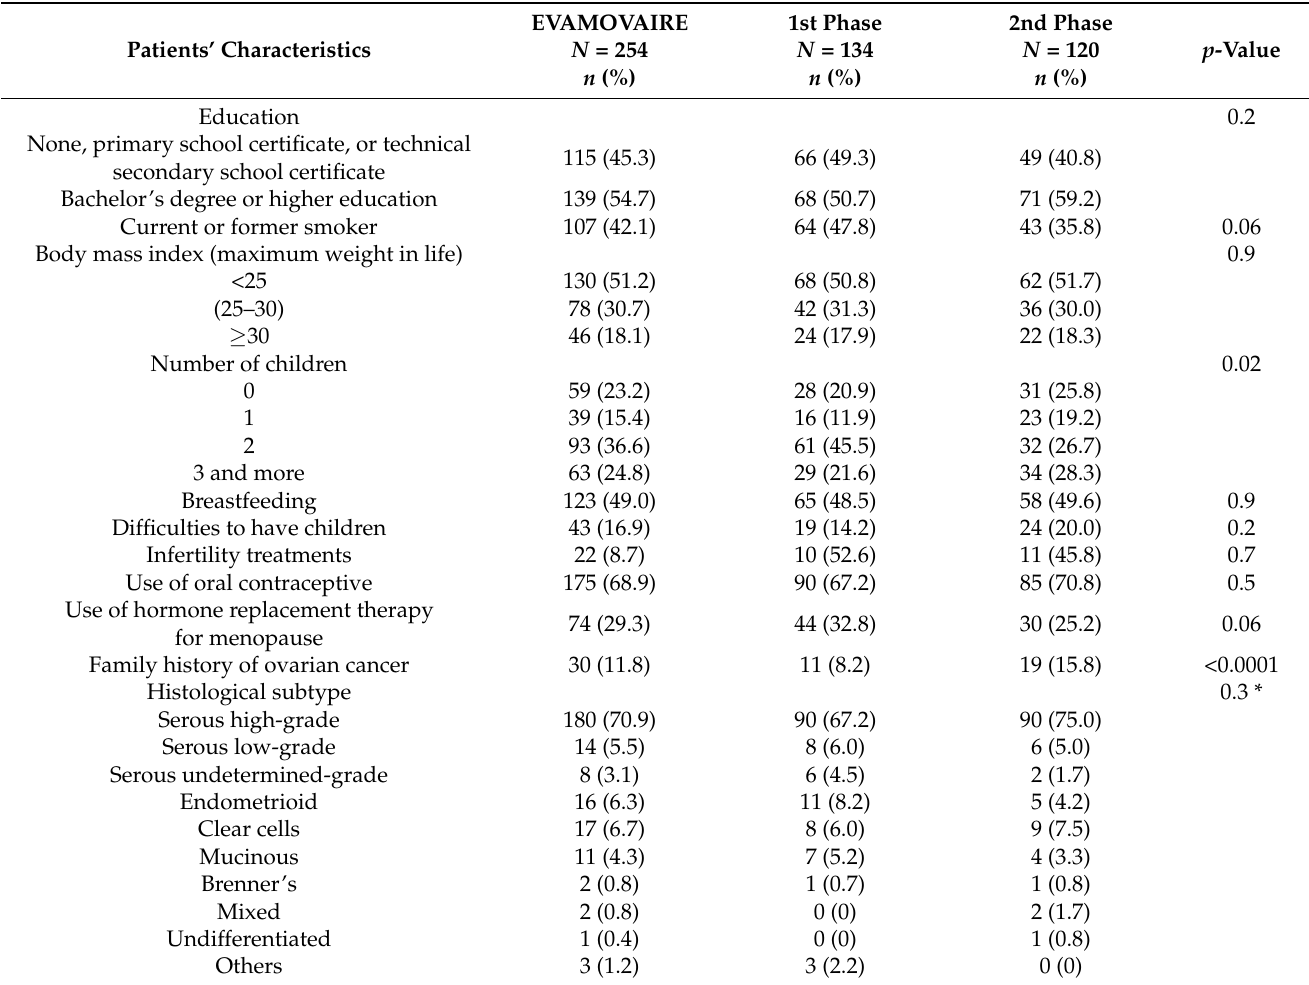
Table 1. Patient